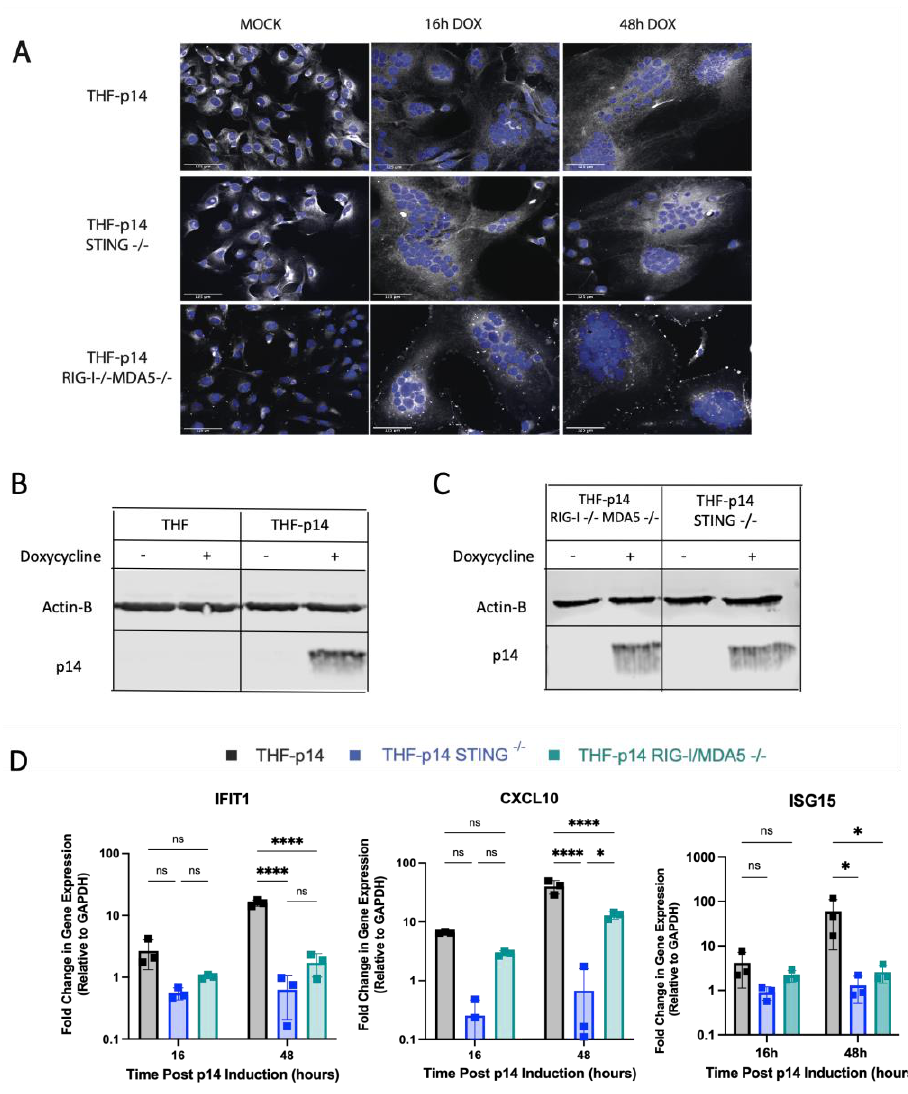
Figure 6. Both STING and RLRs are involved in the ISG response to endogenous p14. ( A ) STING − / − and RIG-I − / − MDA5 − / − THF cells were modified to express p14 under a Tet-On inducible promoter. The cell nuclei were stained with Hoechst 33,342 (blue), and the cell membranes were stained with CellMask Deep Red (white). Scale bar indicates a size of 125 µ m. ( B ) Protein extracts from p14-THF RIG-I − / − MDA5 − / − , p14-THF STING − / − or p14-THF wildtype cells were separated by SDS-PAGE and probed with p14- and beta actin-specific antibodies. ( C ) Protein extracts from p14-THF RIG- I − / − MDA5 − / − and p14-THF STING − / − were separated by SDS-PAGE and probed with p14- and beta actin-specific antibodies. ( D ) p14-THF RIG-I − / − MDA5 − / − , p14-THF STING − / − and p14-THF wildtype cells were treated with 0.01 µ g/mL of doxycycline for 16 or 48 h, and cellular RNA was harvested for RT-qPCR. The transcript levels were normalized to GAPDH level and are shown relative to those in uninduced cells (Time 0). Groups were compared by two-way ANOVA with Bonferroni post-tests (* for p < 0.05 and **** for p <